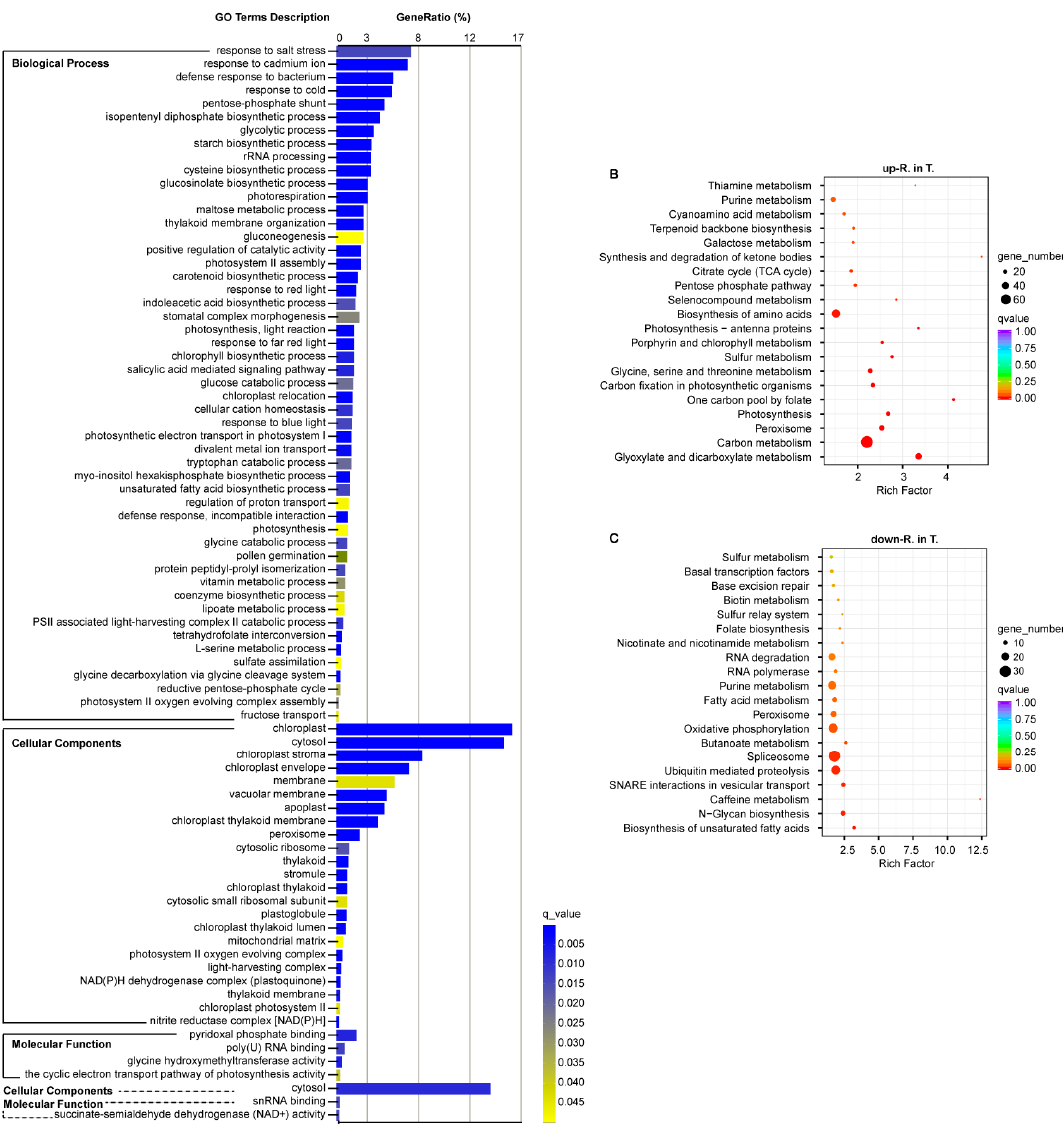
Figure 5. Significantly enriched terms and pathways for the selected DEGs. ( A ) Significant GO terms enriched by the up (full line) and down (broken line) expressed genes in line 2205. GO terms were classified into three groups (BP, CC, and MF). The top 20 KEGG pathways are shown for the genes from “up-R. in T” ( B ) and “down-R. in T” ( C ).